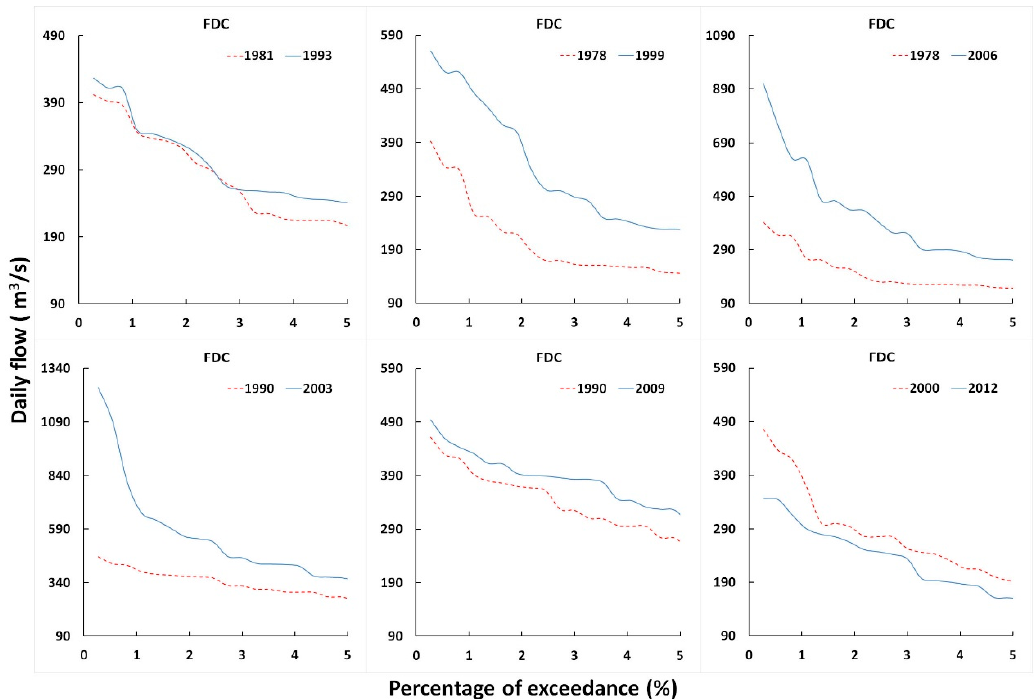
Figure 7. The selected paired years for high flow: 1981 vs 1993 (Period 1 vs Period 2) ( a ), 1978 vs 1999 (Period 1 vs Period 3) ( b ), 1978 vs 2006 (Period 1 vs Period 4) ( c ), 1990 vs 2003 (Period 2 birch vs Period 3 birch) ( d ), 1990 vs 2009 (Period 2 vs Period 4) ( e ), 2000 vs 2012 (Period 3 vs Period 4) ( f ).